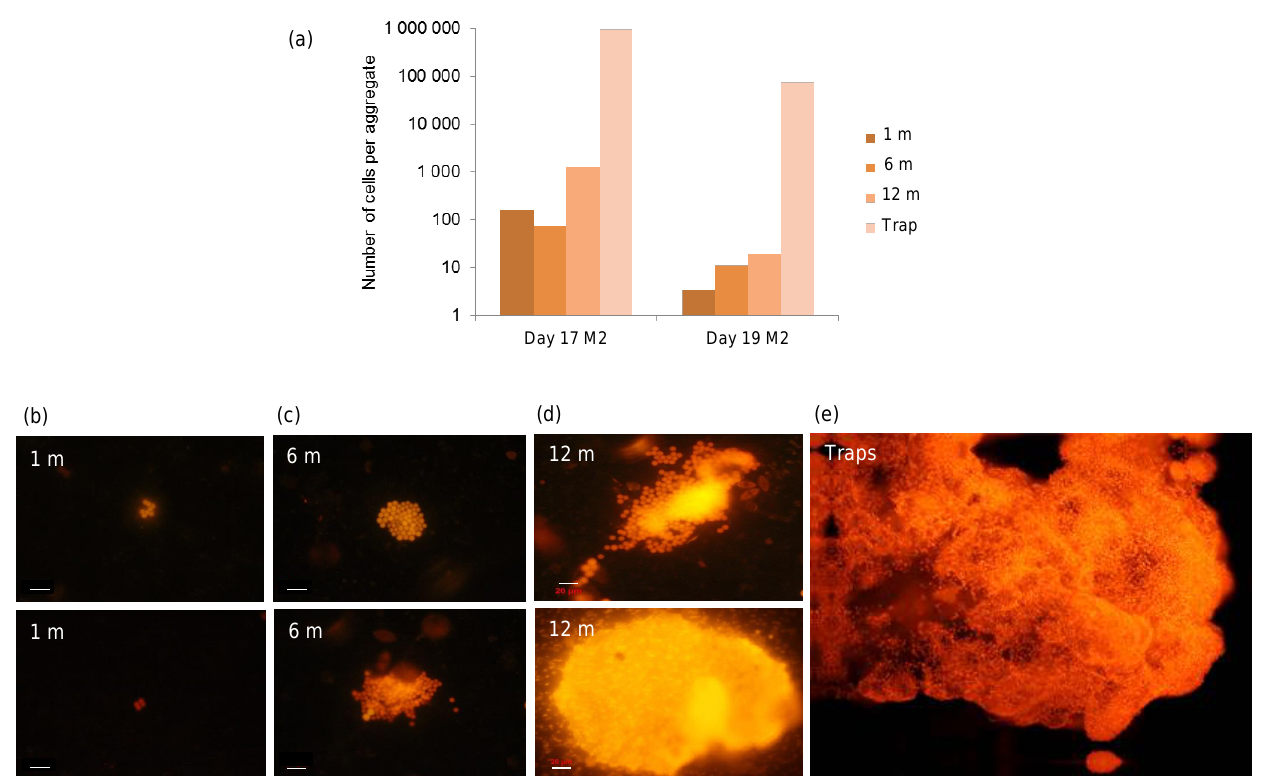
Figure 3. (a) UCYN-C cells per aggregate in M2 on day 17 and 19. (b–e) Green excitation (510–560nm) epifluorescent replicate micrographs of UCYN-C on day 17 taken at 1m depth ( × 40) (b) , 6m depth ( × 40) (c) , 12m depth ( × 40) (d) , and in the sediment traps ( × 10) (e) . Scale bar 20µm (b–d) and 100µm (e)